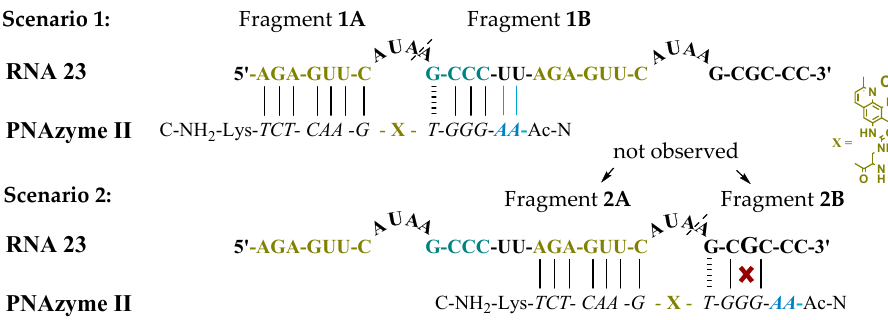
Figure 1. Possible complexes between RNA 23 and PNAzyme II. The dashed line denotes the cleavage site.